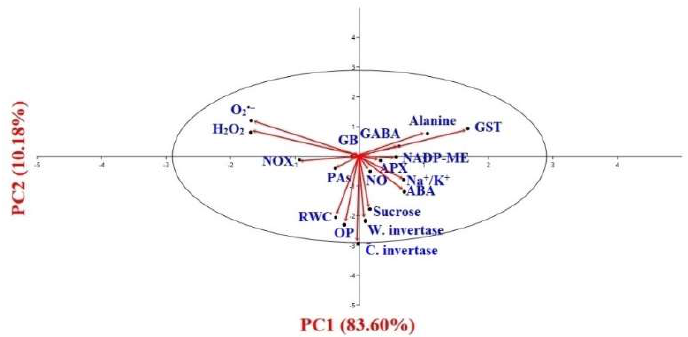
Figure 11. Two-dimensional scatter diagram of principal component analysis based on the first and second principal component of different attributes performed in the experiment. Loading plot: